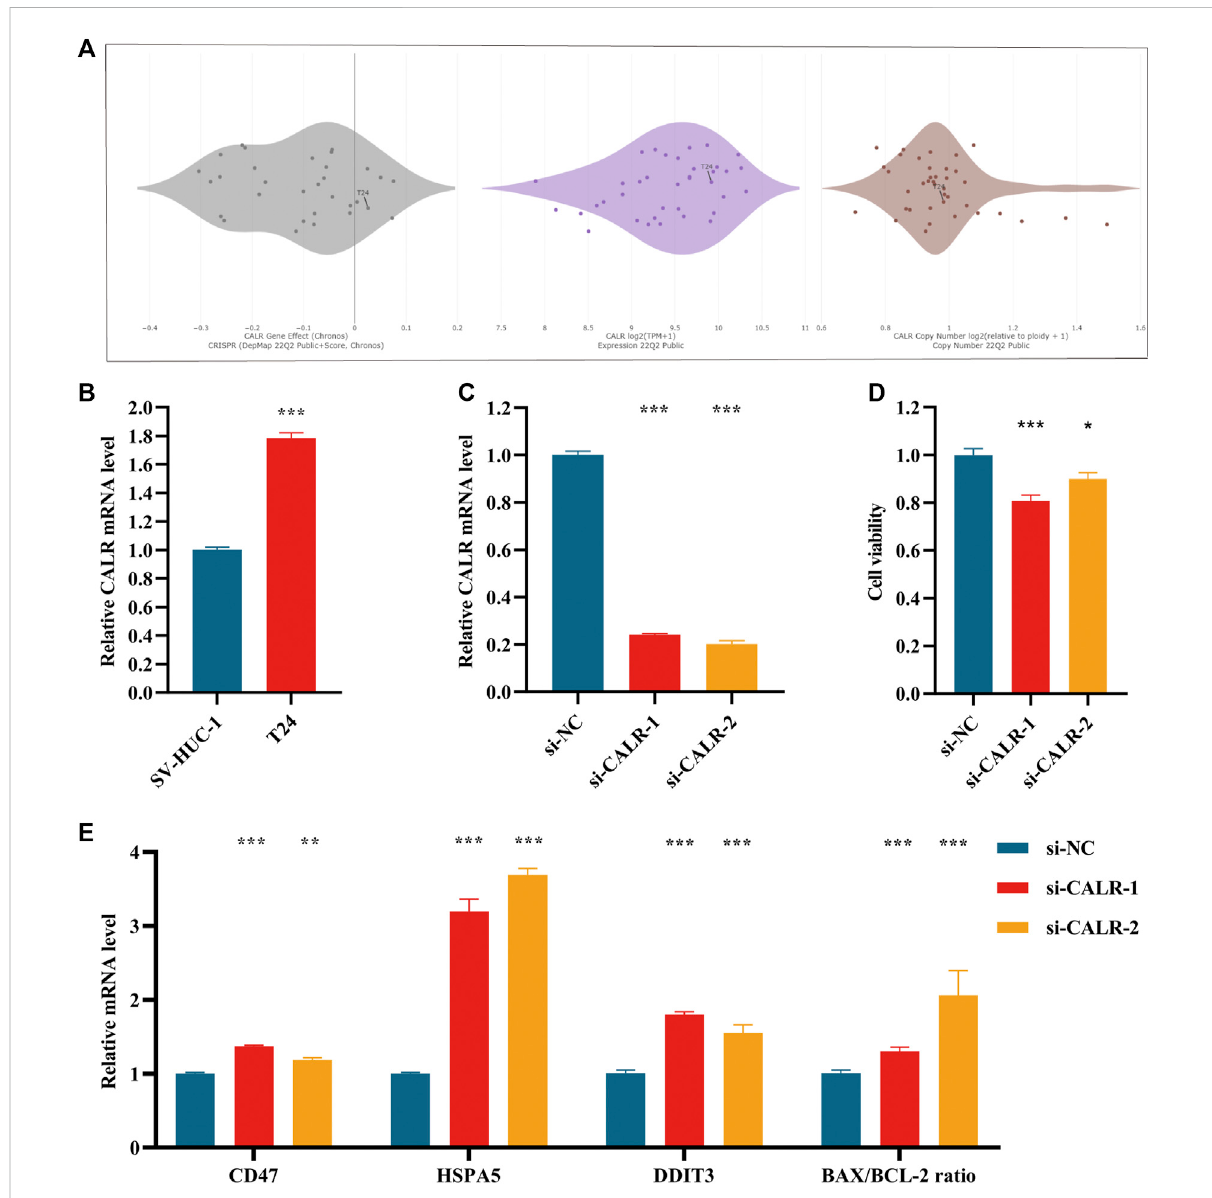
FIGURE 9 CALR expression in bladder cancer cell lines. (A) CALR expression of bladder cancer cell lines in different data sets in CCLE database. (B) Evaluation of the relative CALR/ β -Actin mRNA expression levels, normalized with the SV-HUC-1 cell group. (C) Evaluation of the mRNA expression levels of CALR in si-NC, si-CALR-1 and si-CALR-2 T24 cells using quantitative PCR, with the expression levels normalized to those of β -ACTIN. (D) CCK8 assay was used for cell viability of si-NC, si-CALR-1 and si-CALR-2 T24 cells and normalized with the si-NC group. (E) Evaluation of the mRNA expression levels of CD47, HSPA5, DDIT3, BAX and BCL-2 in T24 cells treated with si-NC, si-CALR-1, or si-CALR-2. Experiments were performed in triplicates. All data are expressed as mean ± standard error (SE). The asterisk symbol indicated the statistical p -value. (* p < 0.05; ** p < 0.01; *** p <